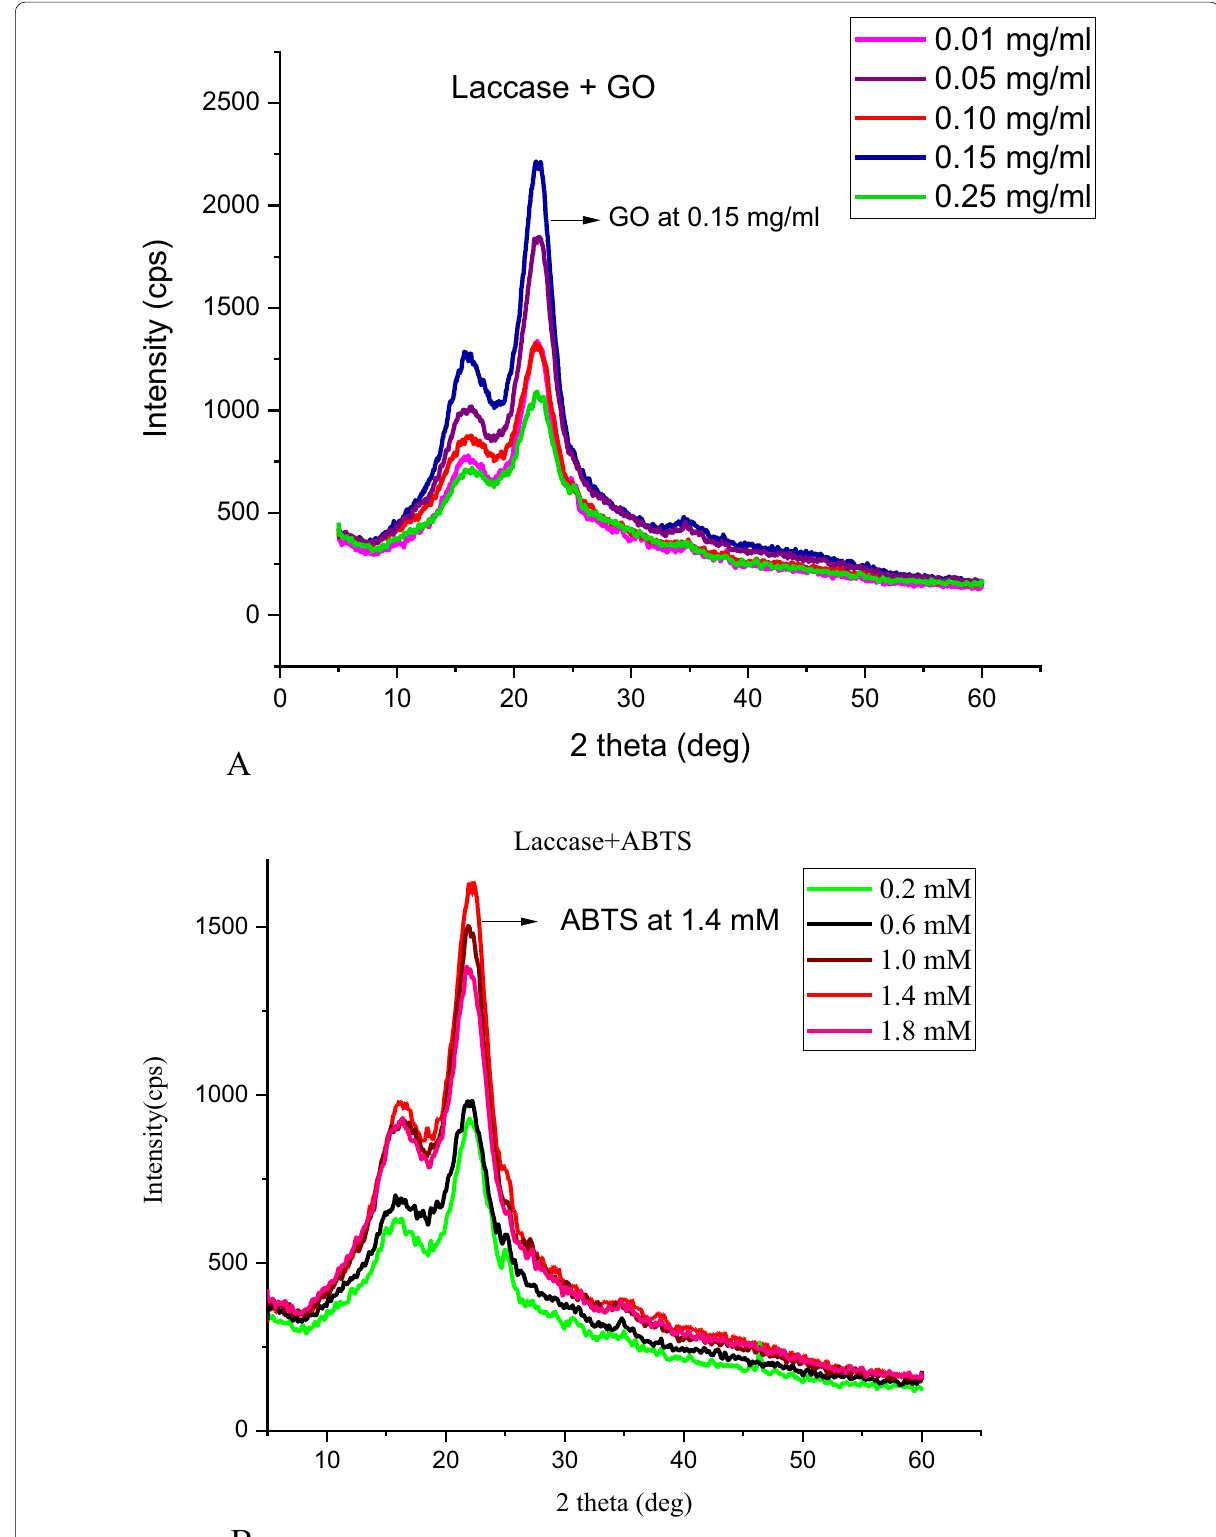
Fig. 4 A X-ray diffractogram for different concentrations of GO with laccase. B X-ray diffractogram for different concentrations of ABTS with